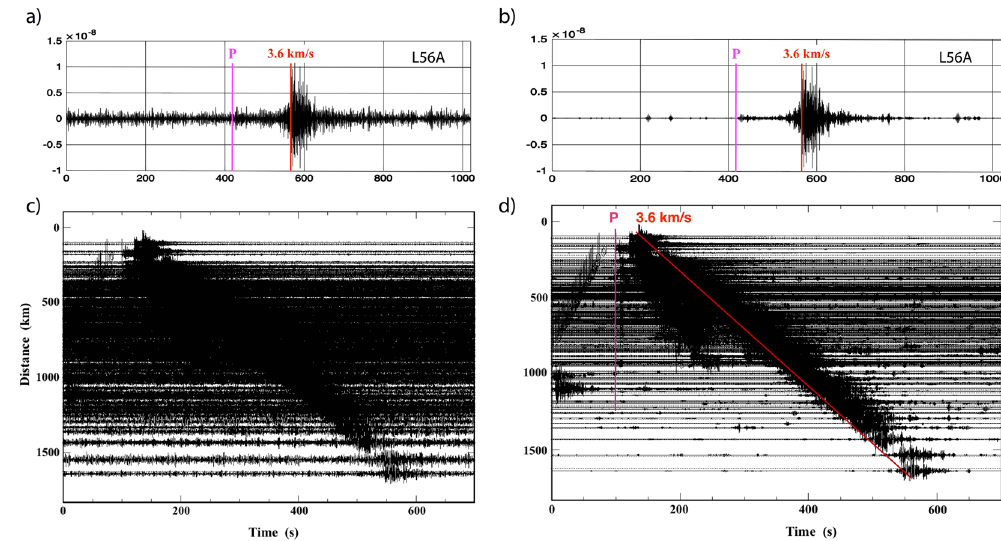
Figure 3. A sample seismogram (top) and associated plot record sections (bottom) from a M 3.5 event that occurred in July 2015 to the south of Nova Scotia, before ( a ) and after ( b ) the denoising. Associated record sections are presented in ( c , d ). P arrival and group velocity of 3.6 km/s are marked on the denoised record